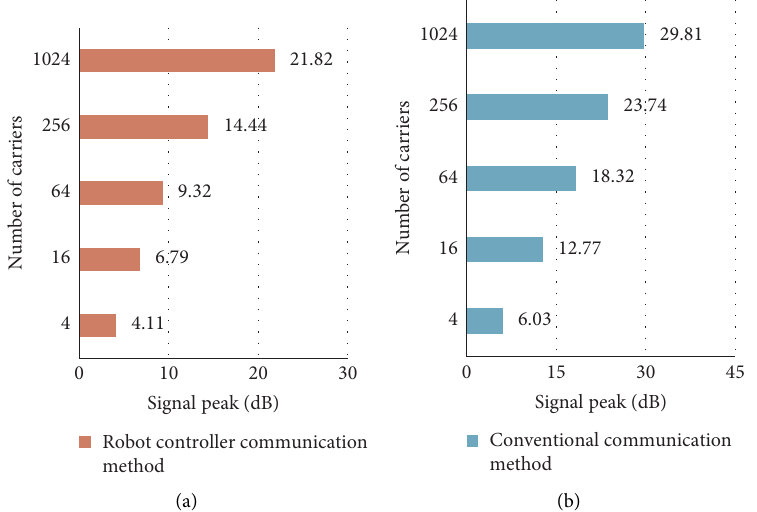
Figure 7: Test efect of signal suppression. (a) Te results of the communication method in this paper. (b) Te results of the conventional communication